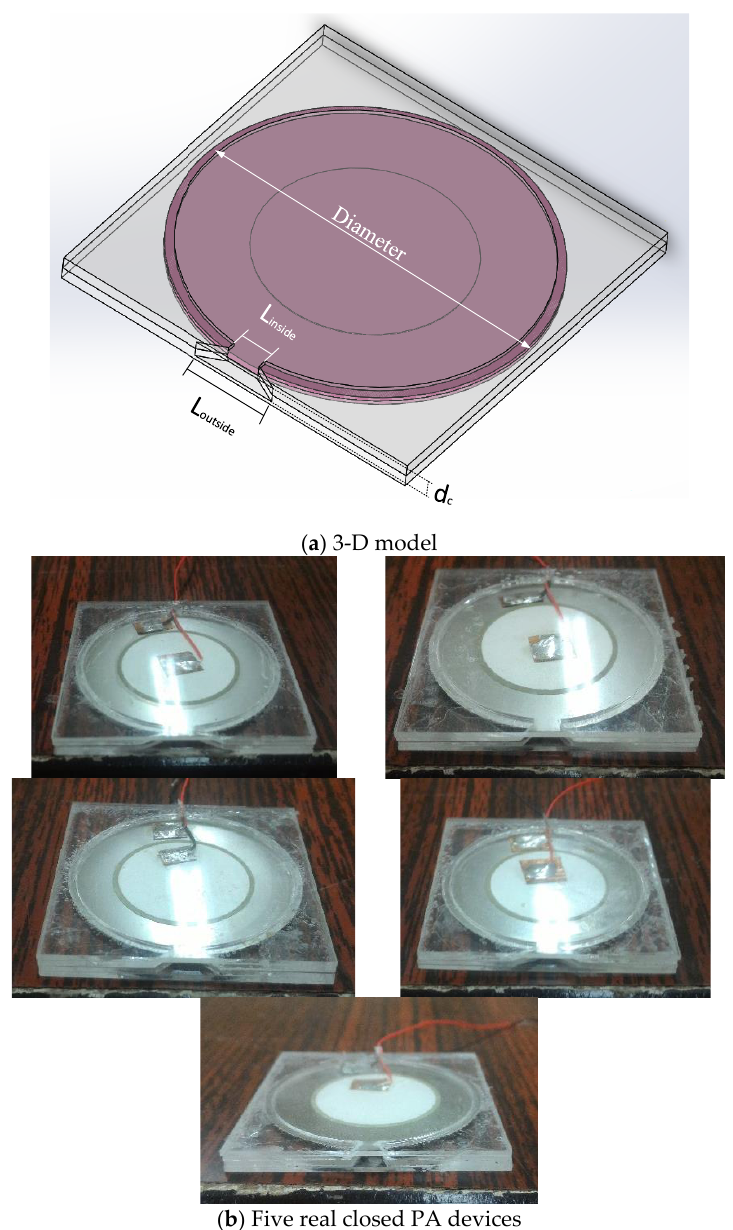
Figure 4. Schematic diagram of closed PA.